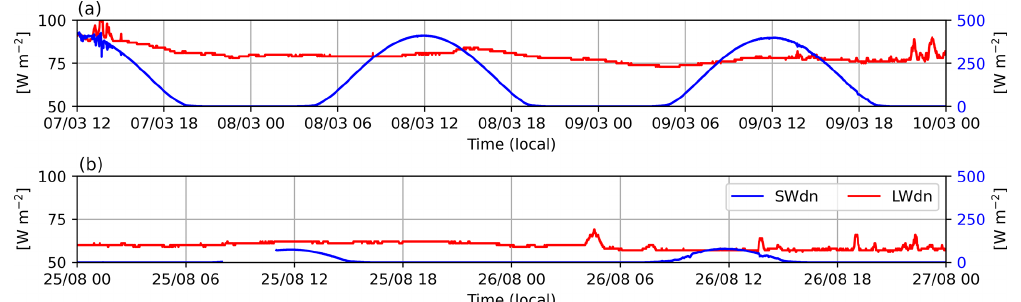
Figure B2. Time series of downward longwave (LWdn, red) and shortwave (SWdn, blue) radiative fluxes at the surface during the first (a) and second (b) case